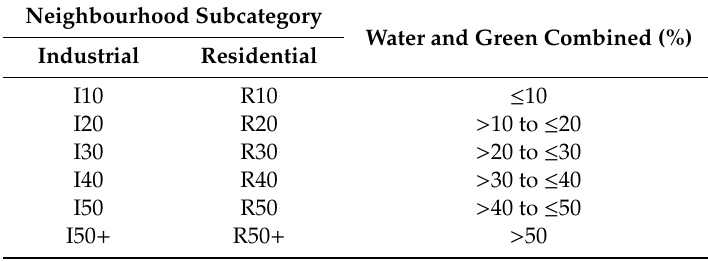
Table 5. Criteria used for the subcategorization of the industrial and residential